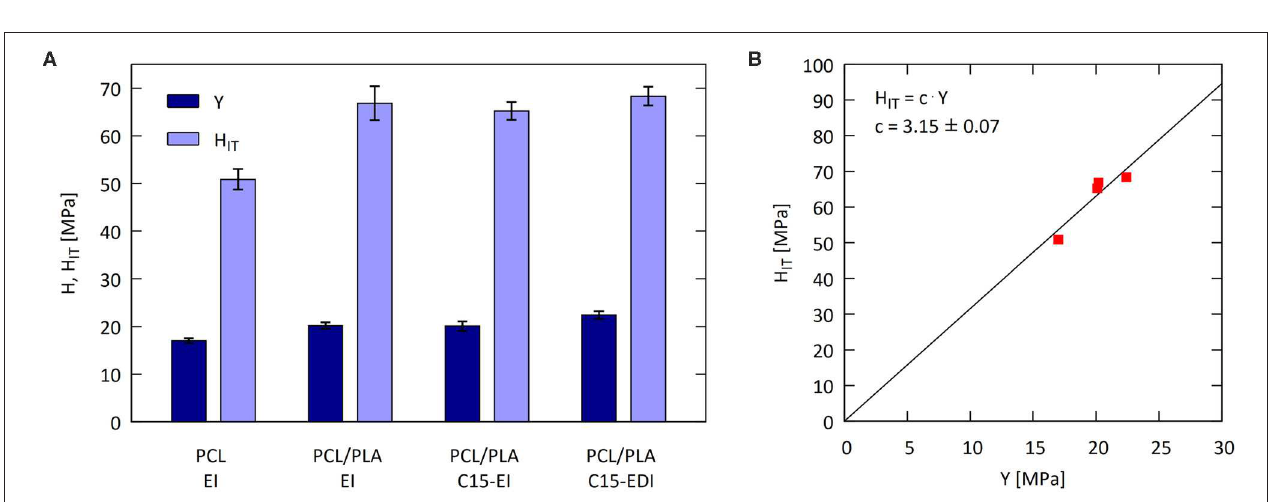
FIGURE 7 | Yield stress and microhardness of the injection molded specimens: (A) comparison of macroscopic yield stress ( Y ) with microscopic indentation hardness ( H IT ) and (B) correlation Y - H IT